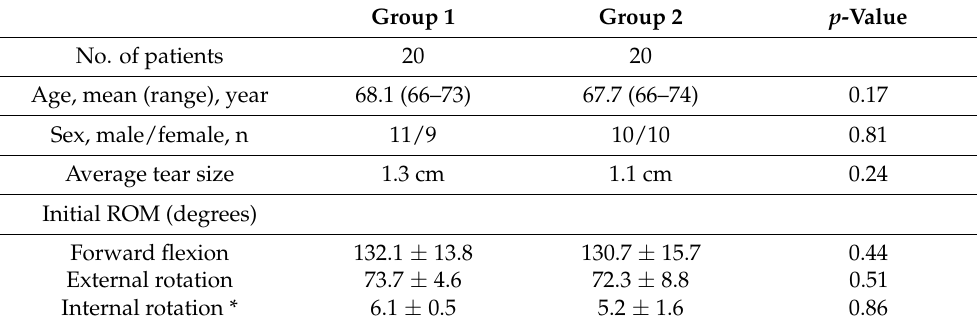
Table 1. Demographic Data of